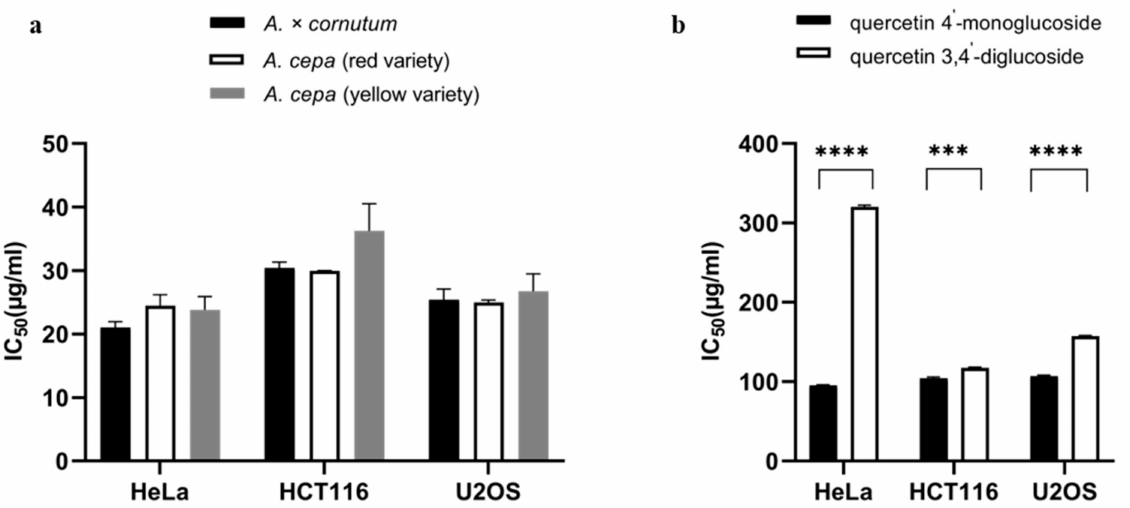
Figure 1. Antiproliferative activity of onion waste extracts ( a ) and quercetin conjugates ( b ) determined by MTS-based cell proliferation assay. The results are expressed as mean values of three independent experiments ± SD (standard deviation). Statistically significant differences are marked with *** p < 0.001 and **** p < 0.0001 (Data S3 and